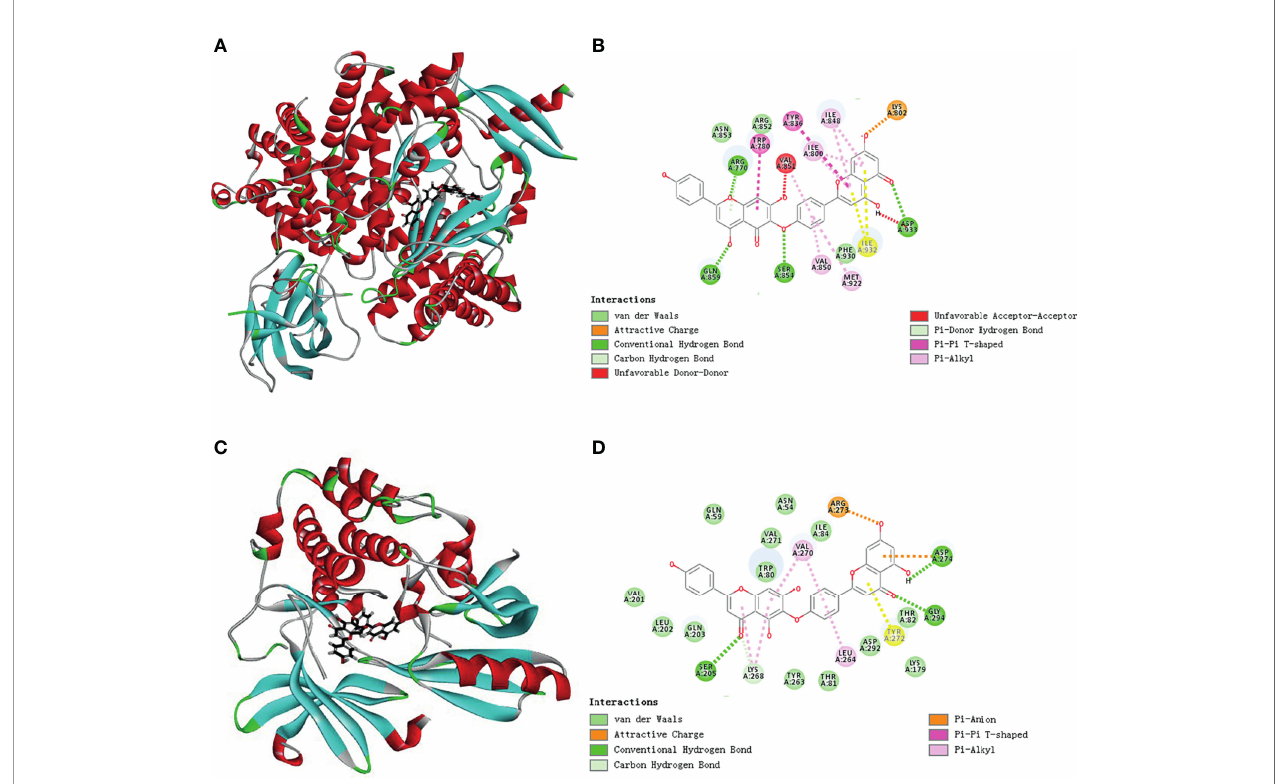
FIGURE 4 | Schematic representation of three- and two-dimensional molecular docking models. (A) Three-dimensional view of HF and PI3K docking scenario. (B) Two-dimensional view of HF and PI3K docking scenario. (C) Three-dimensional view of HF and AKT1 docking scenario. (D) Two-dimensional view of HF and AKT1 docking